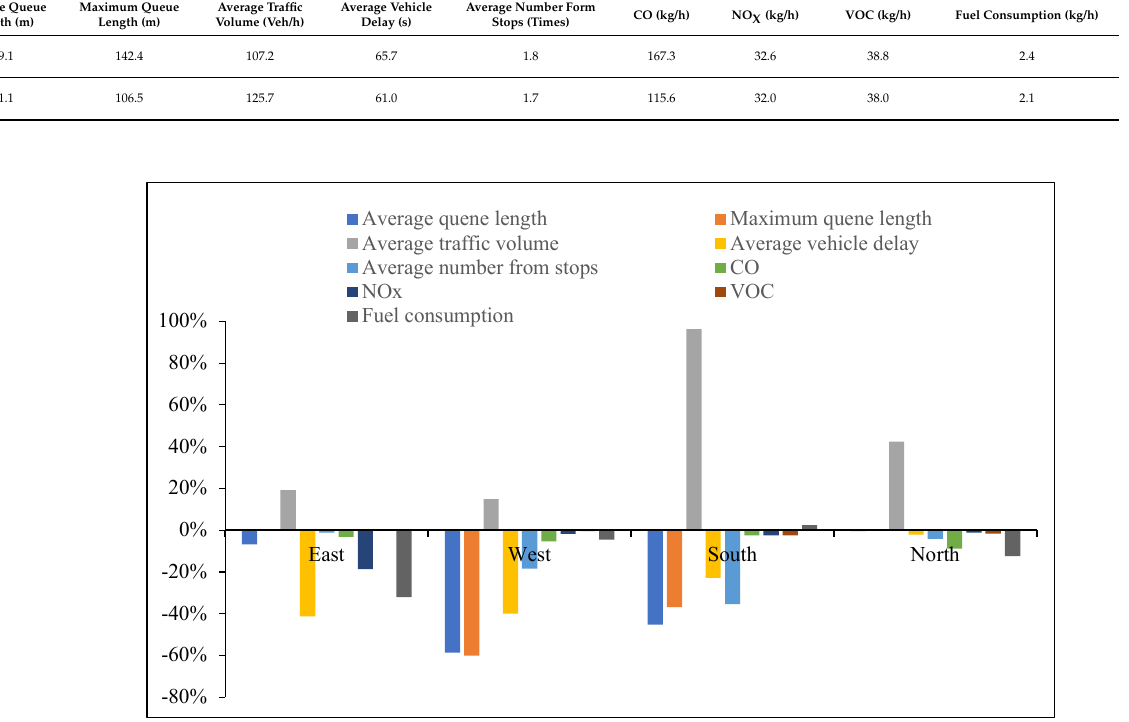
Figure 25. Optimization comparison of No. 5 intersection.